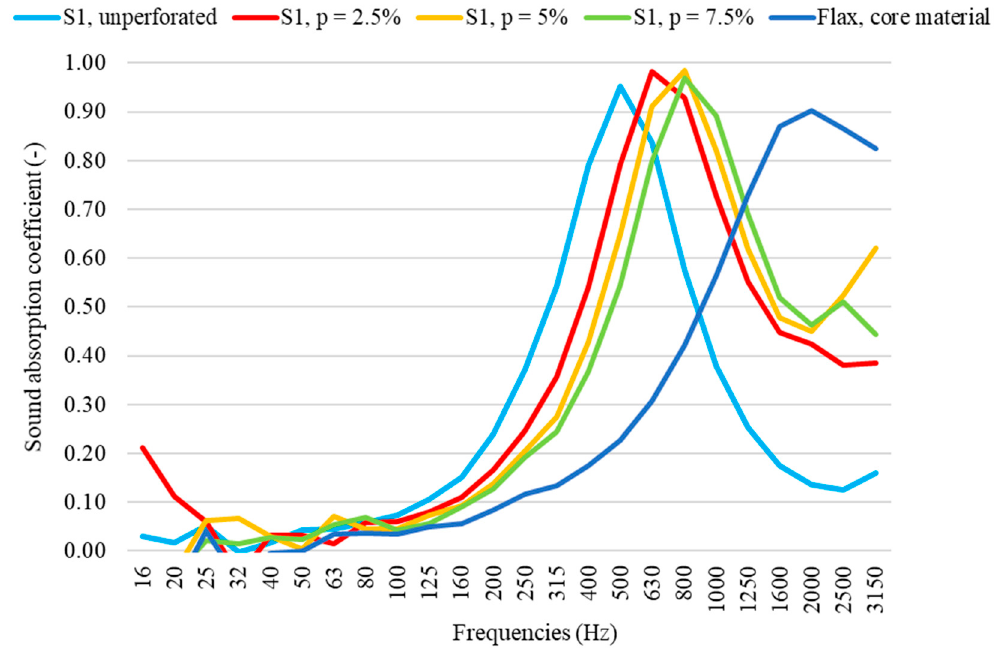
Figure 7. Sound absorption coefficient variation with different perforation percentages (sample S 1 ).